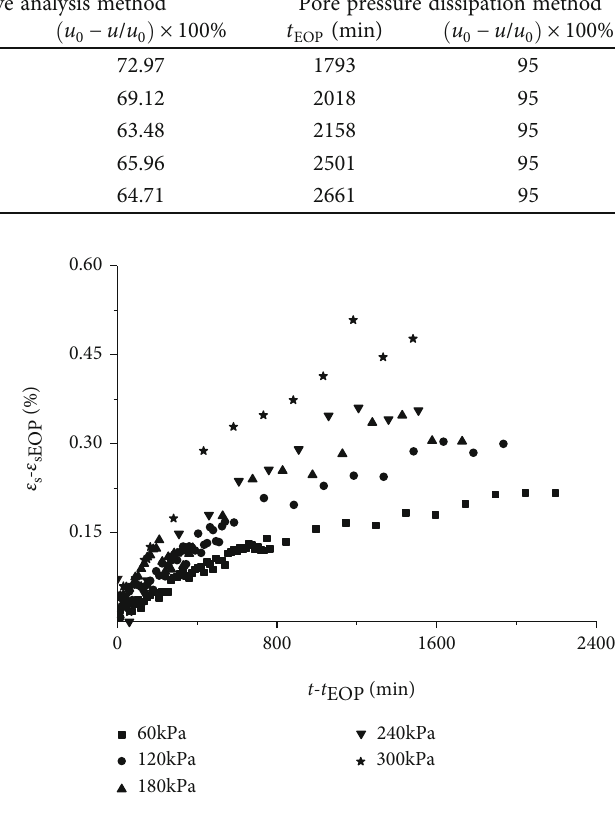
Figure 10: Deviatoric strain creep curve of reconstituted